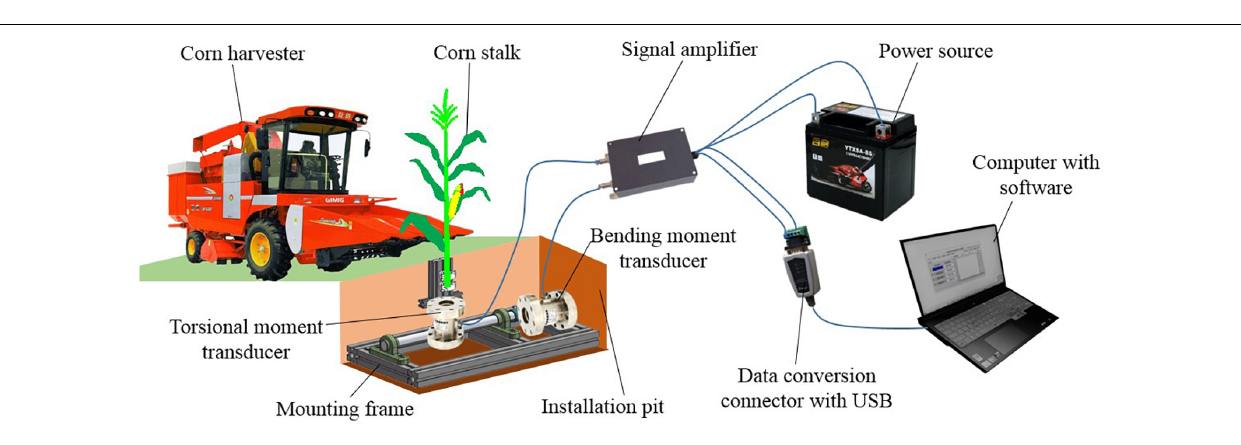
FIGURE 4 | Measurement of forces on corn stalks in